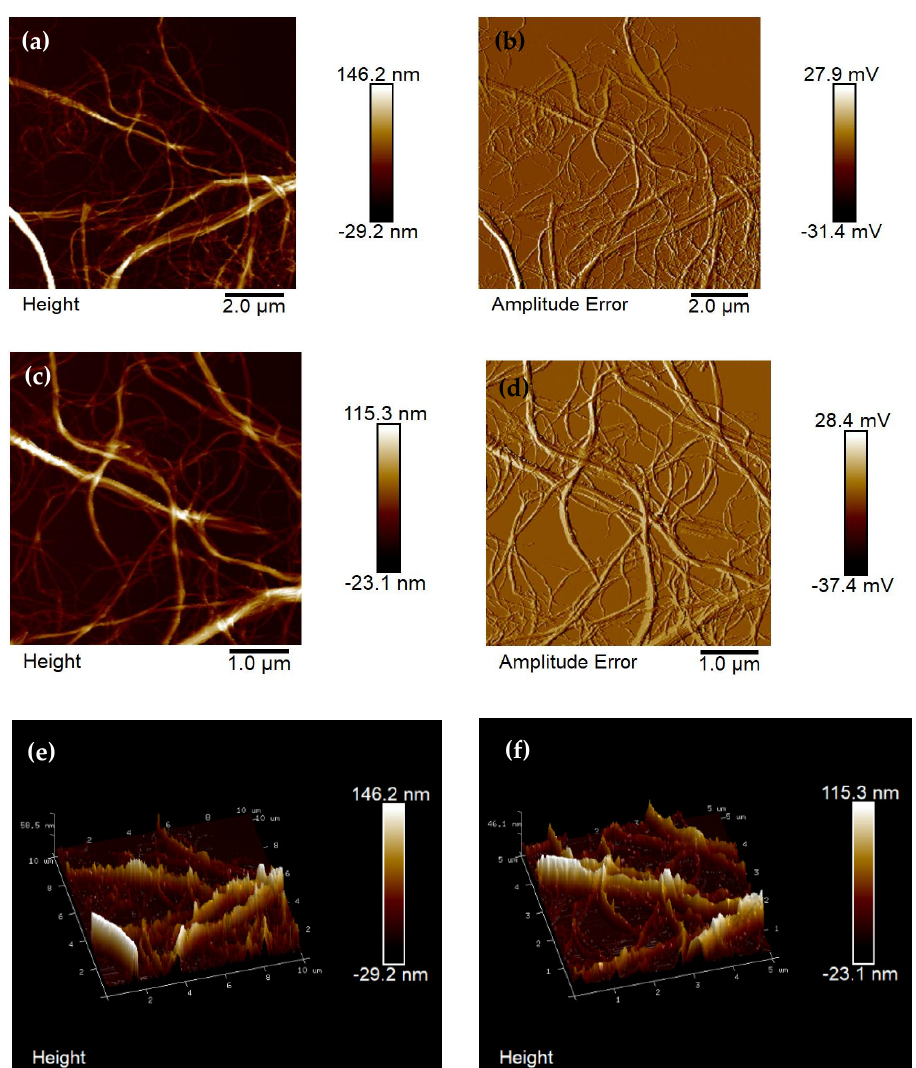
Figure 2. Atomic force microscopy (AFM) image of microfibrillated cellulose (MFC) in tapping mode for a scanned 10 µm × 10 µm area in height ( a ) and amplitude ( b ) and for a scanned 5 µm × 5 µm area at height ( c ) and amplitude ( d ). Three-dimensional phase representation of the scanned 10 µm × 10 µm area ( e ) and 5 µm × 5 µm area ( f ).